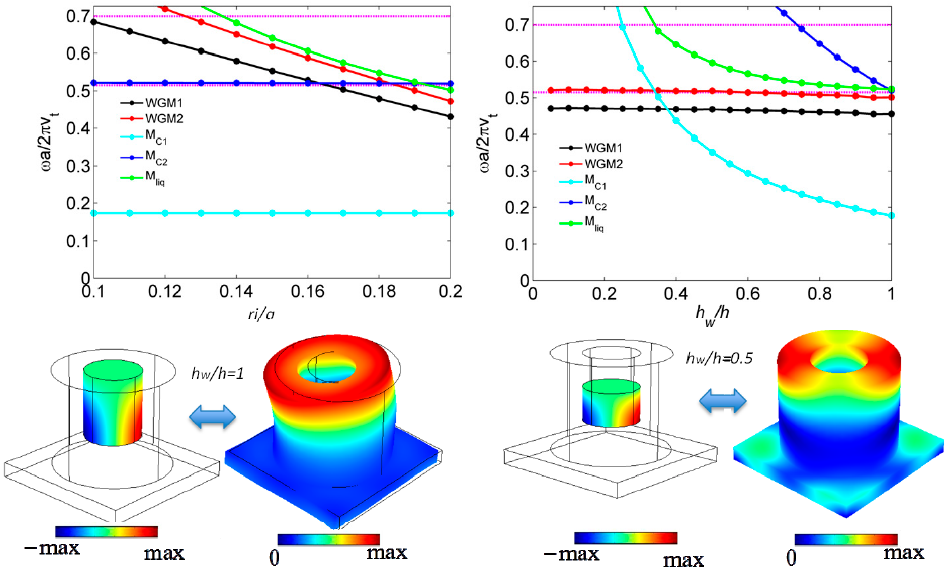
Figure 6. ( Upper-left panel ): evolution of WGM1 ( black dotted line ), WGM2 ( red dotted line ), M c1 ( cyan dotted line ), M c2 ( blue dotted line ), M liq ( green dotted line ) as a function of inner radius when the hollow pillars are fully filled with water ( h w /h = 1). The two horizontal pink dotted lines are the limits of Bragg band gap of the full PnC; ( Upper-right panel ): evolution of WGM1 ( black dotted line ), WGM2 ( red dotted line ), M c1 ( cyan dotted line ), M c2 ( blue dotted line ), M liq ( green dotted line ) as a function of the height of filling water h w /h when the inner radius is r i /a = 0.19. ( Lower panel ): representation of the acoustic (pressure) and elastic (displacement) field of the mode M liq respectively in the fluid and solid part for h w /h = 1 (left) and h w /h = 0.5 (right) when r i /a = 0.19. The other geometric parameters are h/a = 0.45, r/a = 0.4, l/a = 0.2.